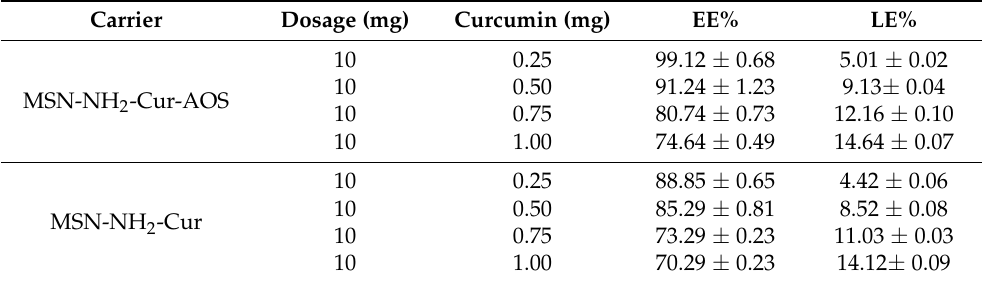
Table 4. The encapsulation and loading efficiency of MSN-NH 2 -Cur-AOS and MSN-NH 2